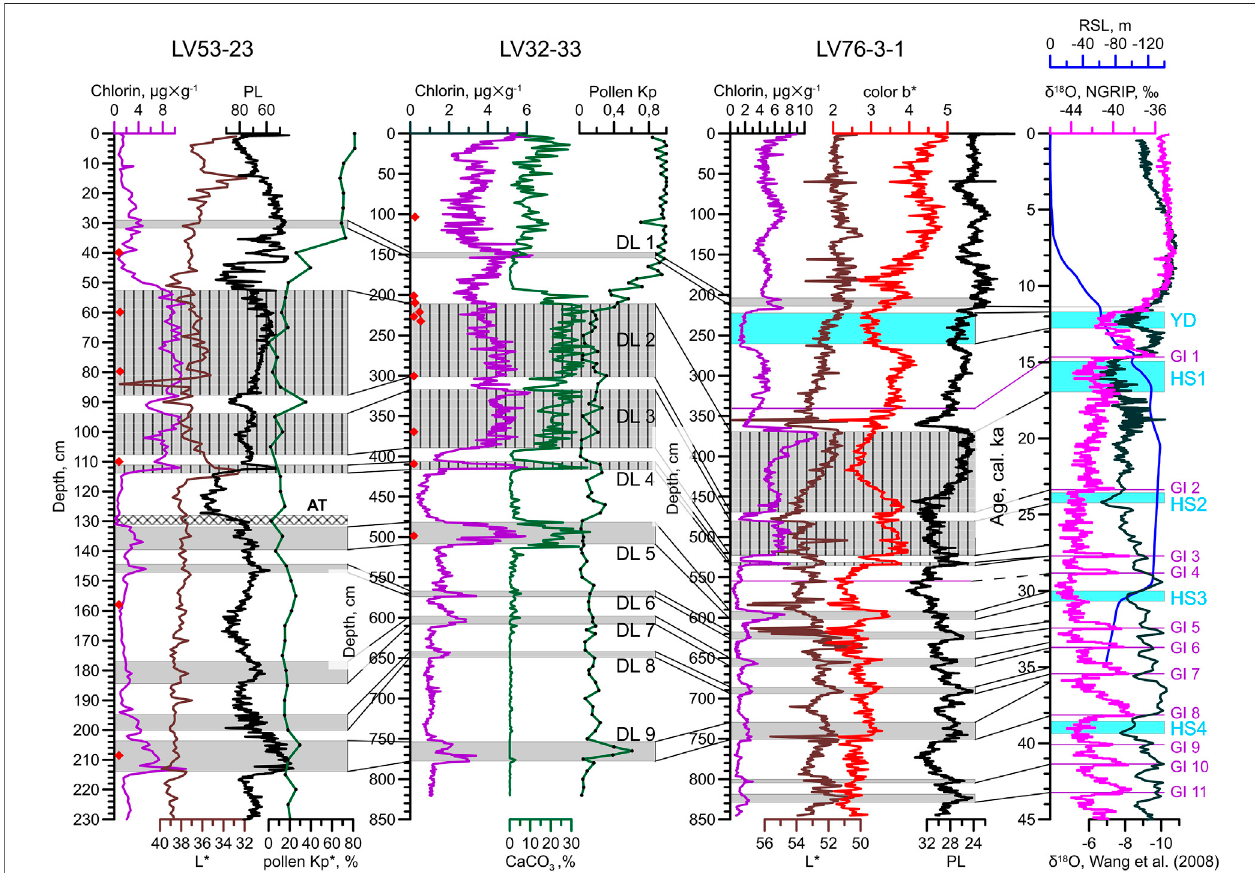
FIGURE6| Correlationofthephoto lightness (PL),colorparameters L*andb*,CaCO 3 and chlorincontentandpollen-derivedclimate-inducedKpand Kp*indices in the cores LV53-23, LV32-33 and LV76-3-1 with Greenland Interglacials (GIs) and Heinrich Stadials (HSs) of NGRIP δ 18 O record (Seierstad et al., 2014), summer East Asian monsoon intensity (Wang et al., 2008) and relative sea level (RSL) changes (Lambeck et al., 2014). Gray bars show the locations of the dark layers (DL). Hatched barsshowthinlaminatedDLs.BluebarsshowHSs1 – 4andcoldYoungerDryasevent(YD).Cross-hatchedbarshowsthelocationoftephralayerATincoreLV53- 23. Purple horizontal lines indicate GIs. Red rhombs indicate AMS 14 C dating of cores LV32-33 and LV53-23-1.